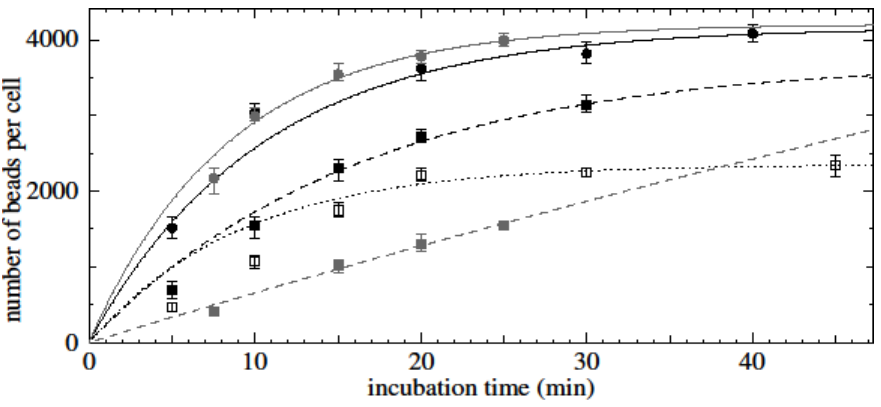
Figure 4. Time-dependent binding of anti-CD3 conjugated magnetic nanobeads to untouched CD3-positive cells. In this figure and the next, data are fitted to saturation-type curves of the form A (1 − exp(− kt )) where t is the incubation time. Solid black and grey line and round dots: 32 µg beads/100 µL, 10 6 cells/100 µL, R 2 = 0.95 and 0.99 (cells from two different donors); black dashed line and square dots: 32 µg beads/100 µL, 2 × 10 6 cells/100 µL, R 2 = 0.99; dotted line and squares: 16 µg beads/100 µL, 10 6 cells/100 µL, R 2 = 0.95; grey dashed line and square dots: 8 µg beads/100 µL, 5 × 10 5 cells/100 µL, R 2 =